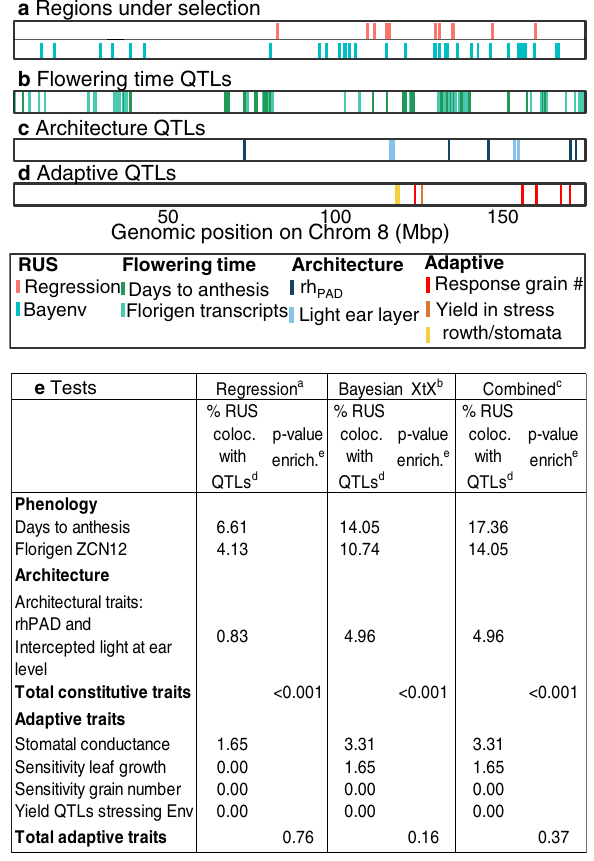
Fig. 8 Regions under selection (RUS) colocalized with QTLs of phenology and architecture traits, not with QTLs of adaptive traits. a Regions under